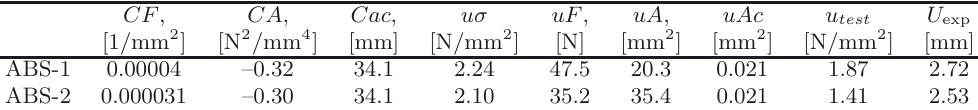
Table 2. Calculations of sensitivity coefficients and uncertainties for the samples.